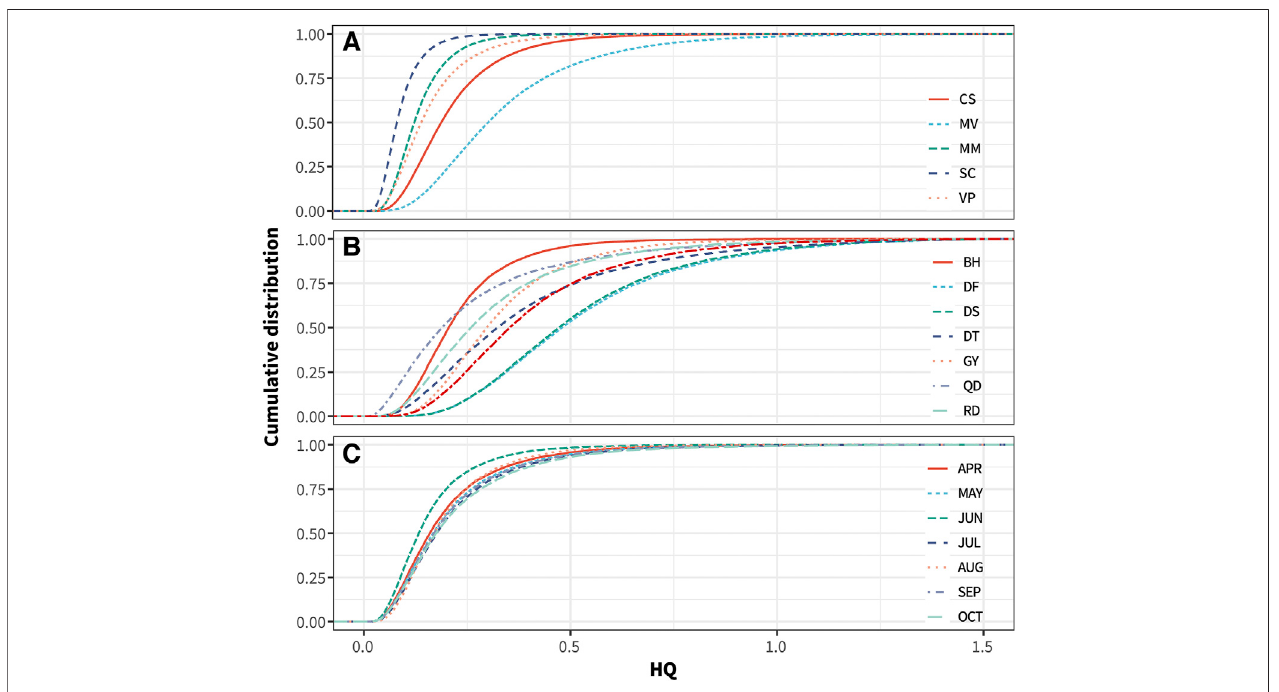
FIGURE 7 | Cumulative probability of HQ of iAs exposure from consumption of different clam species cultivated in Jiangsu for the adult populations of China (A) . Cumulative probability of HQ of iAs exposure from consumption of MV sampling at different locations (B) and seasons (C) in Jiangsu for the adult populations of China.